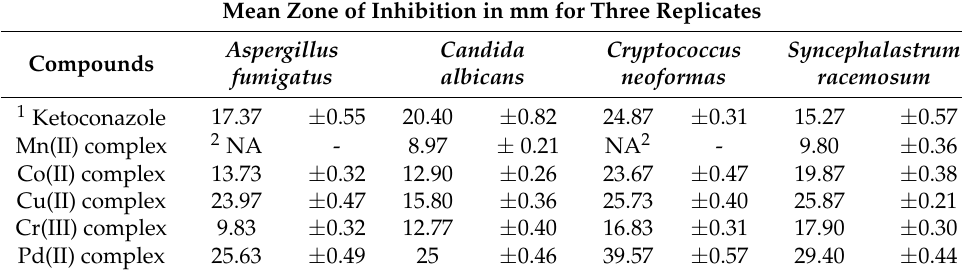
Figure 13. Microbiological screening of coordination compounds of Mn(II), Co(II), Cu(II), Cr(III), and Pd(II) toward Candida albicans. Table 6. Biological activities of the complexes against fungal.